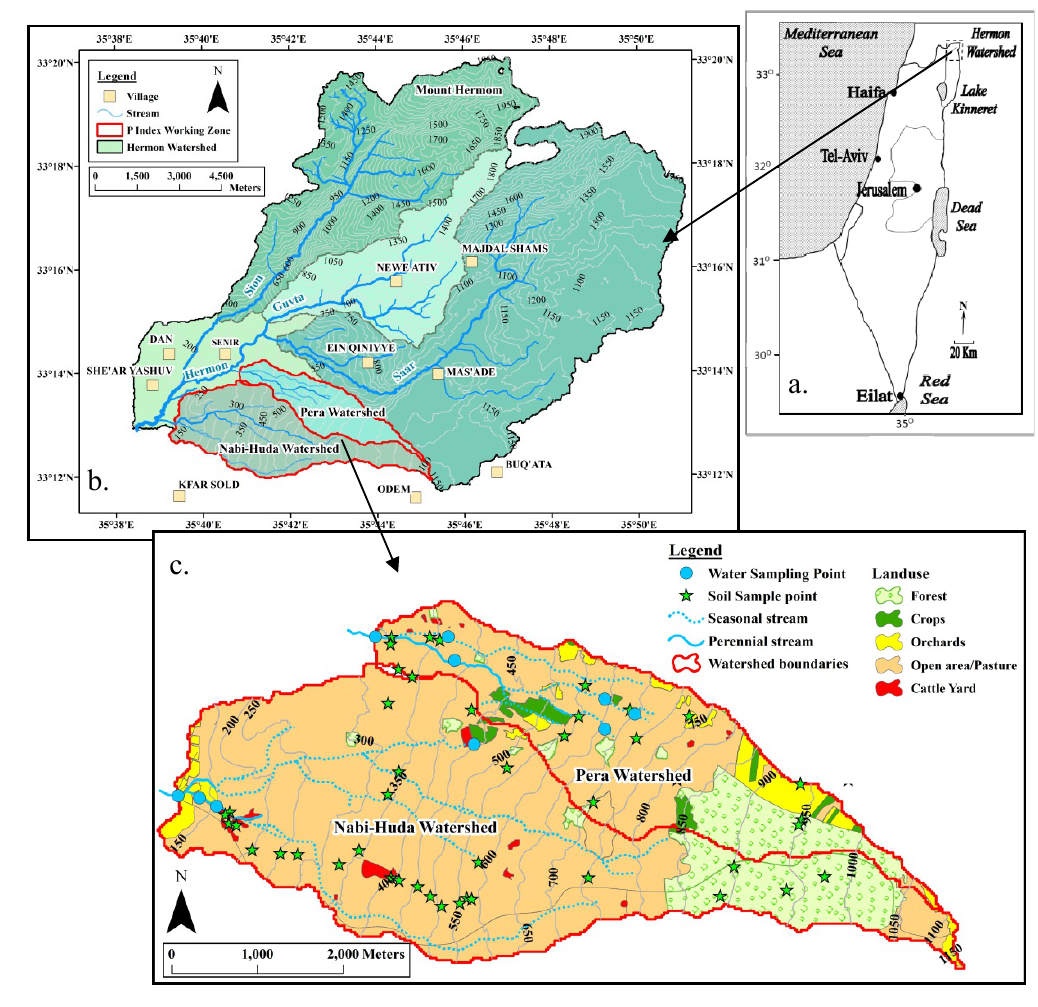
sub-catchments; and ( c ) the current land use and stream sampling